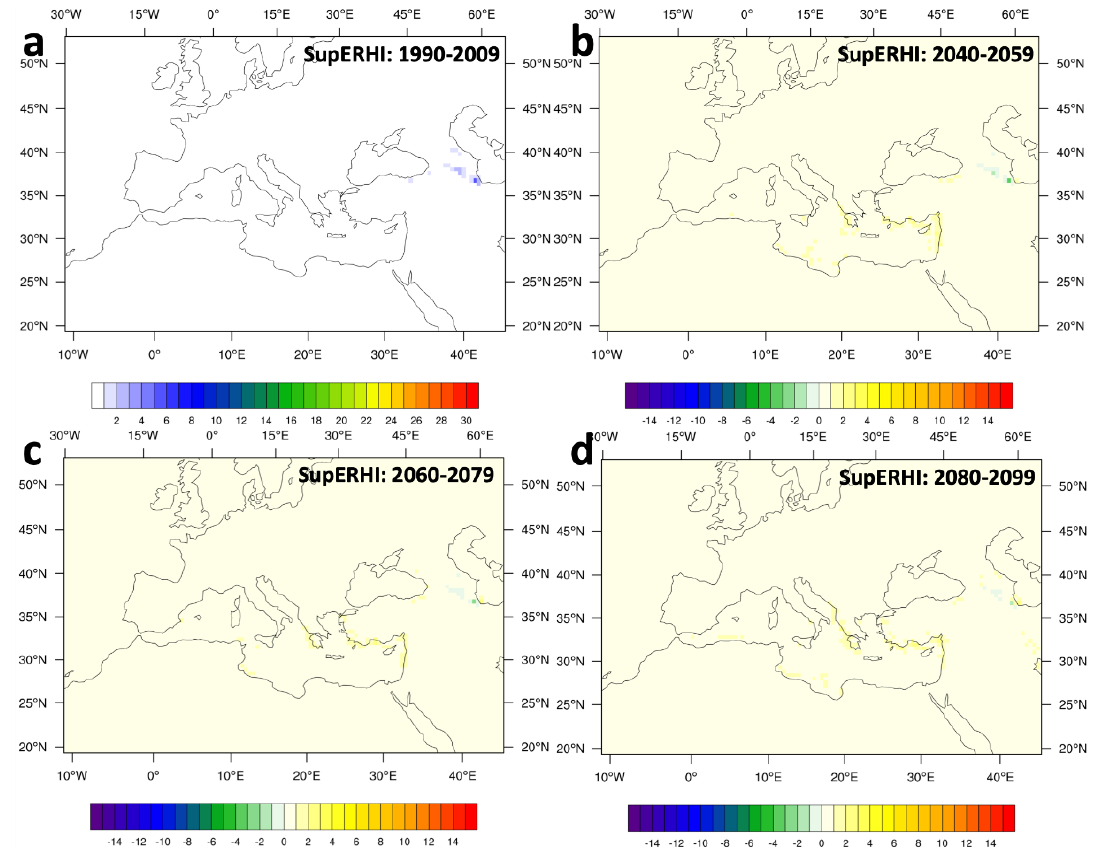
Figure 10. ( a ) Annual average number of days with CAPE ≥ 500 J/kg AND 0–6 km SHEAR ≥ 20 m/s AND convective precipitation rate > 0 mm/h (SupERHI) for 1990–2009, ( b ) changes in average number of days with SupERHI for 2040–2059, ( c ) changes in average number of days with SupERHI for 2060–2079, ( d ) changes in average number of days with SupERHI for 2080–2099.